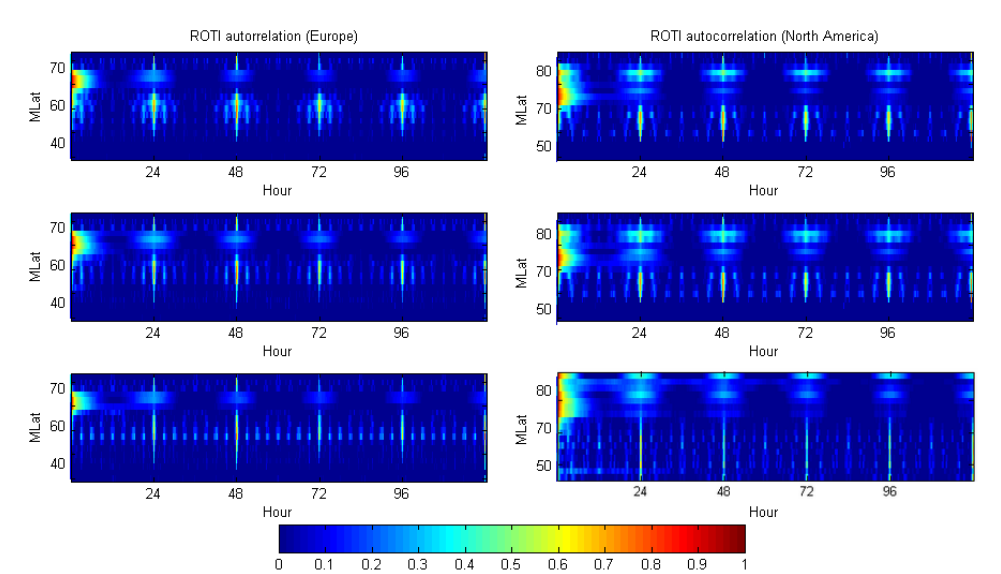
Figure 8. ROTI autocorrelation results as a function of magnetic latitude and time for European ( left column ) and North-American ( right column ) sectors for years 2013, 2015 and 2017